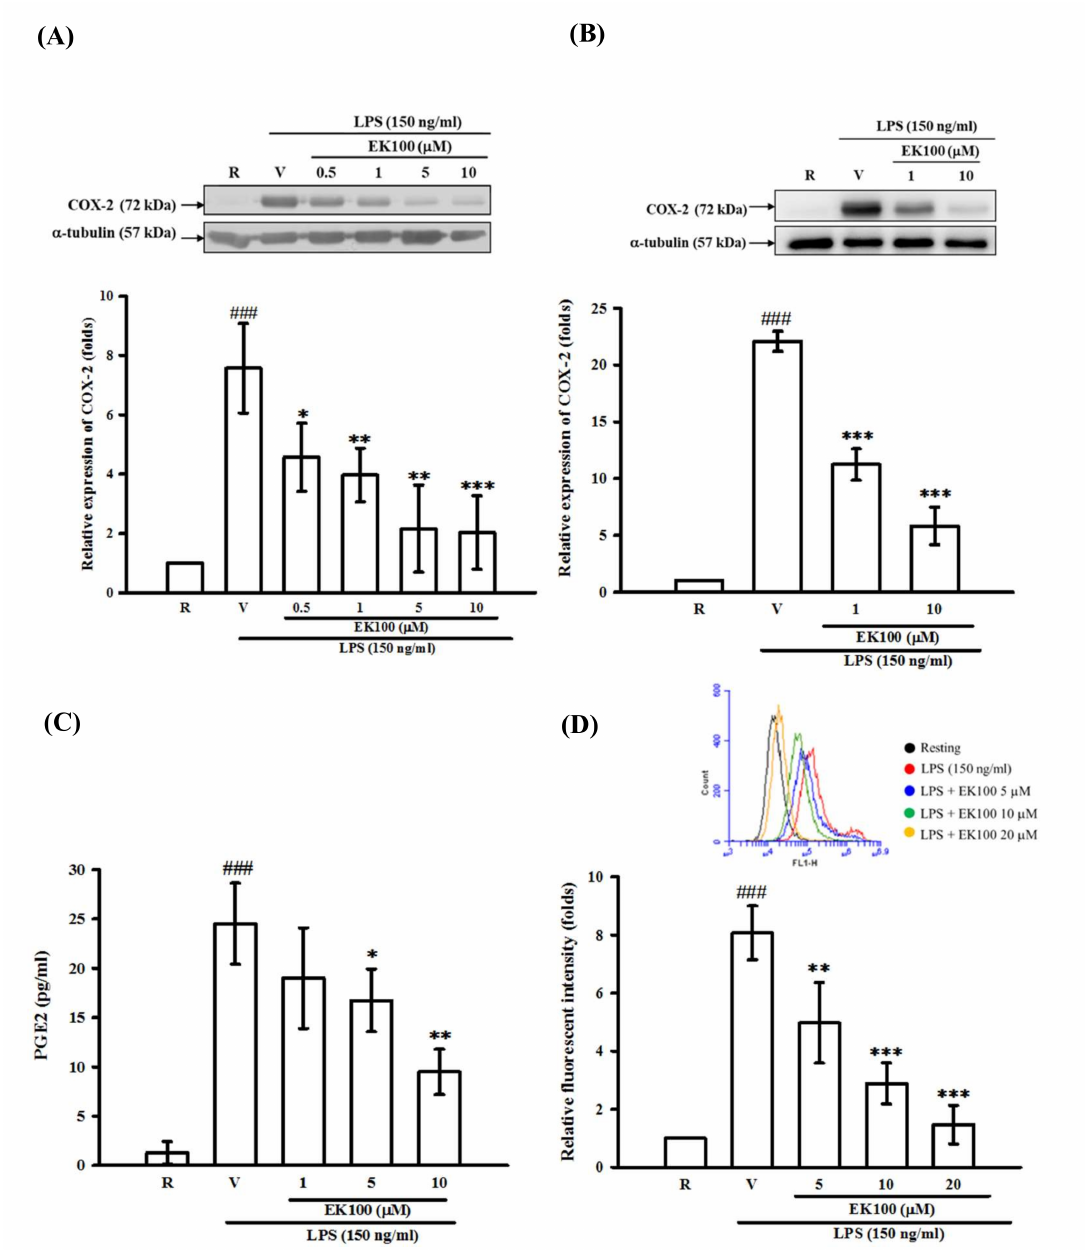
Figure 4. Effects of EK100 on the LPS-induced expression of the COX-2 protein in microglial BV-2 and primary microglial cells, and productions of PGE 2 and ROS. ( A ) BV-2 cells (2 × 10 5 cells/mL) were dispensed on 6-well plates and treated with different concentrations of EK100 (0.5, 1, 5 and 10 µ M) or vehicle (V) for 15 min before stimulation with LPS (150 ng/mL) for 24 h. Then, the cell lysates were obtained and analyzed for COX-2 protein expression by Western blots. The relative changes (folds) were represented as the mean ± SD ( n = 3). ( B ) Primary microglial cells were dispensed on 6-well plates and treated with different concentrations of EK100 (1 and 10 µ M) or vehicle for 15 min before stimulation with LPS (150 ng/mL) for 24 h. The relative changes (folds) of COX-2 protein expression were represented as the mean ± SD ( n = 4). ( C ) PGE 2 contents in conditioned media of BV-2 cells were evaluated by ELISA. The values were analyzed and represented as the mean ± SD ( n = 3). ( D ) The BV-2 cells were pretreated with vehicle or EK100 (5, 10 and 20 µ M) for 30 min, then stimulated with LPS (150 ng/mL) for 24 h. After stimulation, BV-2 cells were purchased and incubated with DCFH-DA for 40 min. Then, the cellular DCF fluorescent intensities were analyzed by flow cytometry (BD AccuriTM C6, NJ, USA). The results were analyzed and represented as the mean ± SD ( n = 3). ### p < 0.001 compared with the resting group (R); * p < 0.05, ** p < 0.01, *** p < 0.001 compared with the vehicle under